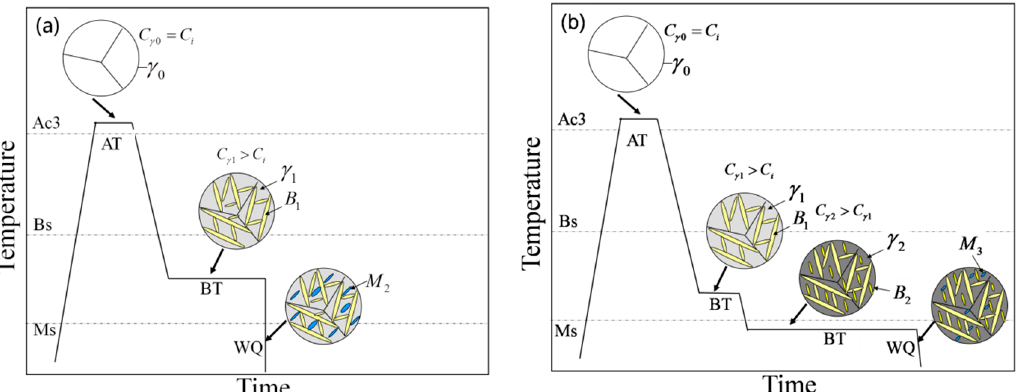
Figure 9. Schematic diagram of bainite transformation: ( a ) one-step and ( b ) two-step techniques (A c3 : temperature of ferrite completely transformed into austenite during heating; Bs: starting transformation temperature of bainite; M S : starting transformation temperature of martensite; AT: austenitizing temperature; BT: bainitic transformation temperature; WQ : water-quenching; γ 0 : austenite microstructure in austenitizing process; γ 1 : austenite microstructure in one-step bainitic transformation process; γ 2 : austenite microstructure in two-step bainitic transformation process; B 1 : bainite microstructure in one-step bainitic transformation process; B 2 : bainite microstructure in two-step bainitic transformation process; M 2 : martensite microstructure in water-quenching process for one-step bainitic transformation; M 3 : martensite microstructure in water-quenching process for two-step bainitic transformation; C i : carbon content of alloy elements; C γ 0 : carbon content of austenite microstructure in austenitizing process; C γ 1 : carbon content of austenite microstructure in one-step bainitic transformation process; C γ 2 : carbon content of austenite microstructure in two-step bainitic transformation process).